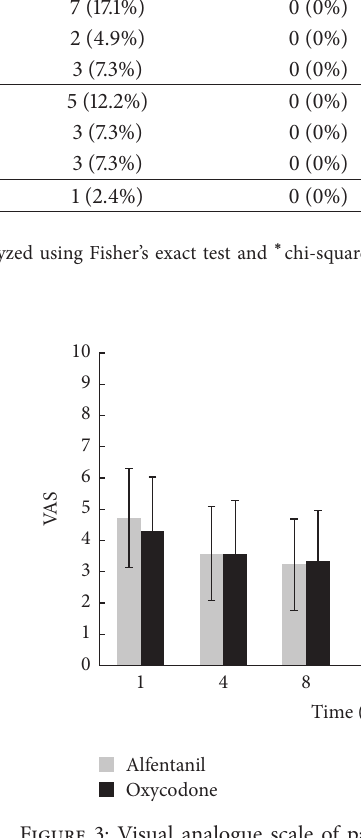
Figure 2: Visual analogue scale of pain during coughing between 1 and 48 h after the operation. Means and standard deviation are shown. 𝑝 values were calculated by repeated-measures analysis of variance. There were no significant differences between two groups ( 𝑝 value < 0.05). VAS: visual analogue scale.